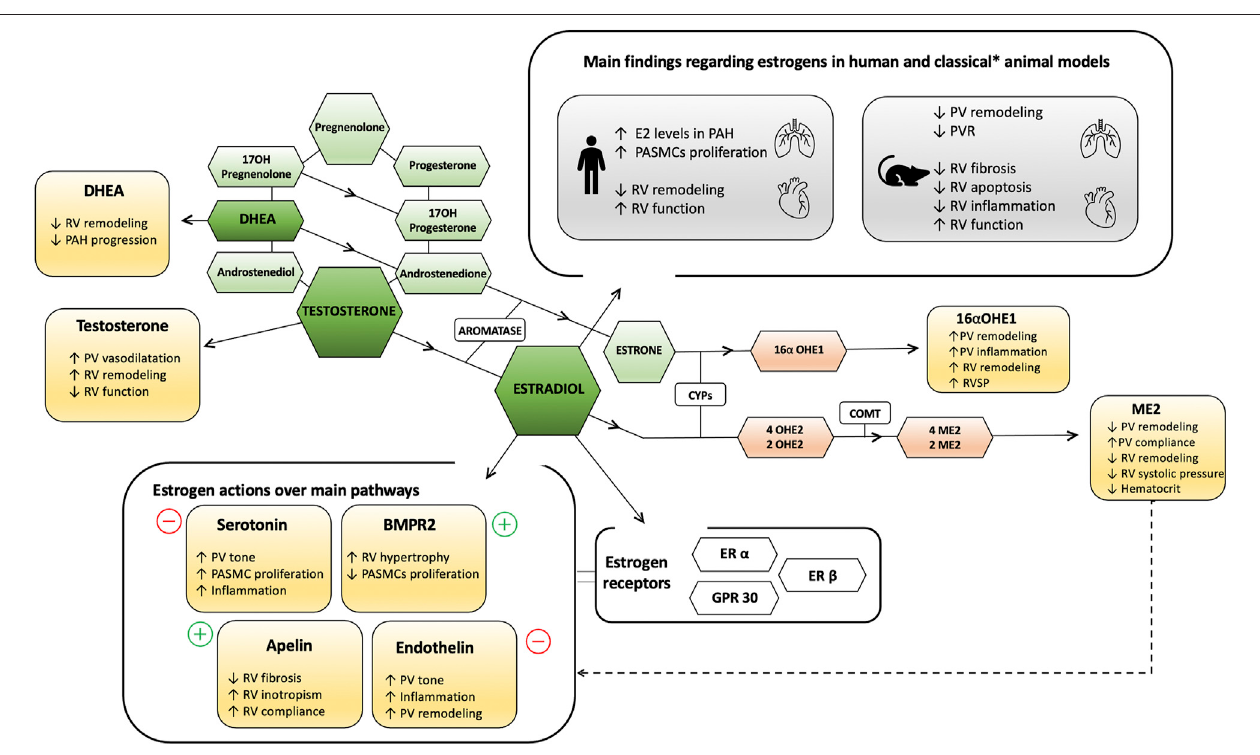
FIGURE 1 | Overview of sex hormones synthesis, metabolism and main effects in humans and animal models. Rectangles refer to main functions. Coloured exagonal forms refer to hormones and metabolites, and non-coloured exagonal forms to enzymes. * Opposite results have been observed in the model of SERT and S100A4/Mts1. +/- referes to upregulation and downregulations of the molecule activity descrived, respectively. 2OHE2, 2 hidroxyestradiol; 2ME2, 2-methoxyestradiol; 4OHE2, 4 hidroxyestradiol; 4ME2, 4-methoxyestradiol; 16 α OHE1, 16 α -hydroxyestrone; BMPR2, Bone Morphogenetic Protein Receptor Type 2; COMT, Catechol-O-methyltransferase; CYPs, cytochrome enzymes; DHEA, dehydroepiandrosterone; E2, estradiol; ER, estrogen receptor; GPR, G protein-couple receptor; OH, hydroxy; PAH, pulmonary arterial hypertension; PASMCs, pulmonary artery smooth muscle cells; PV, pulmonary vascular; RV, right ventricular.